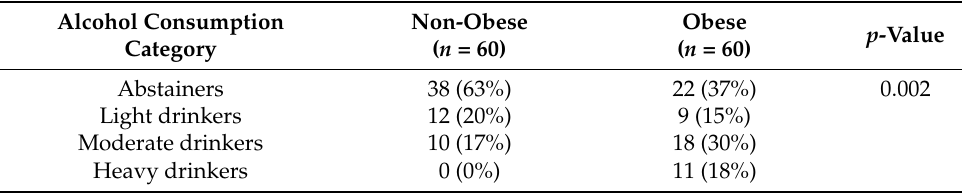
Table 2. Alcohol consumption categories in obese subjects and non-obese controls.